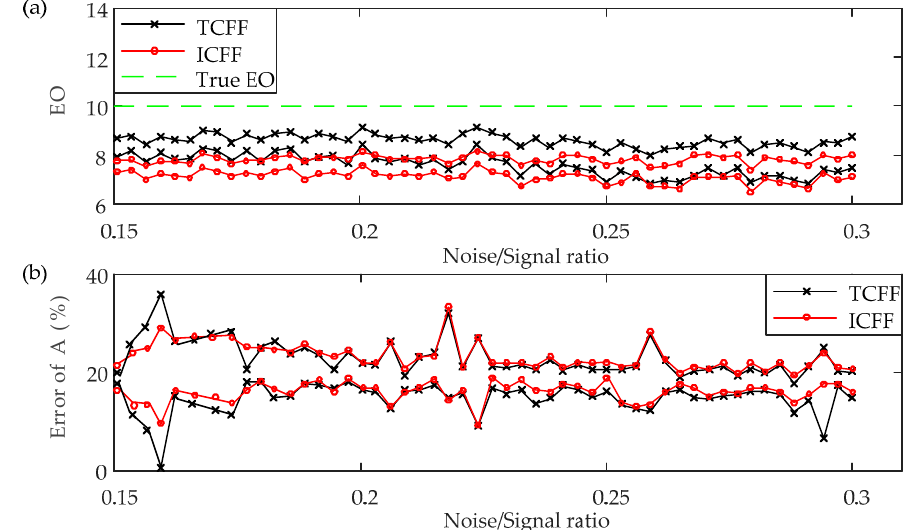
Figure 6. Results of Test 2. ( a ) 95% confidence intervals of the EO identification and ( b ) 95% confidence intervals of the relative error of the amplitude identification.